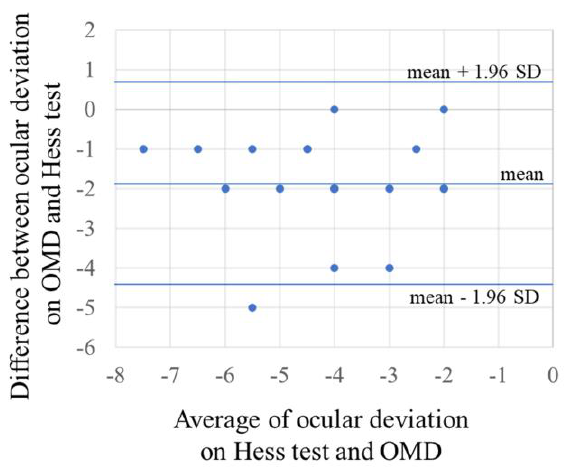
Table 1. Comparison of the nine gaze-direction meas-urements with the Hess screen test and the new objective OMD. The Hess screen test cannot be used for evaluating patients with suppression because the grid is displayed in one eye and the target is displayed in the other eye under red–green dichoptic separation (Pratt-Johnson & Tillson, 1984). gaze-direction